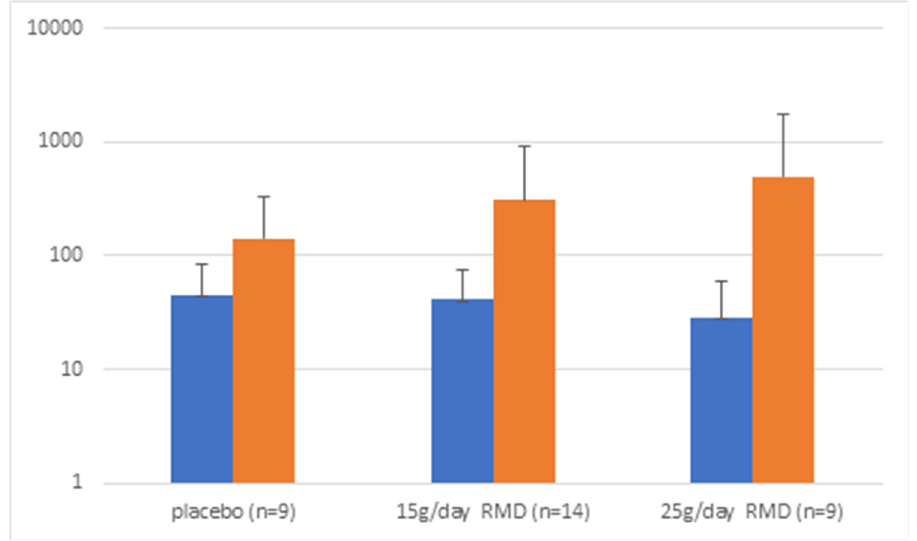
Figure 2. LAB genome copies/10 ng DNA in samples with low LAB content at beginning of each period. Blue: baseline of intervention period; Orange: end of intervention period.